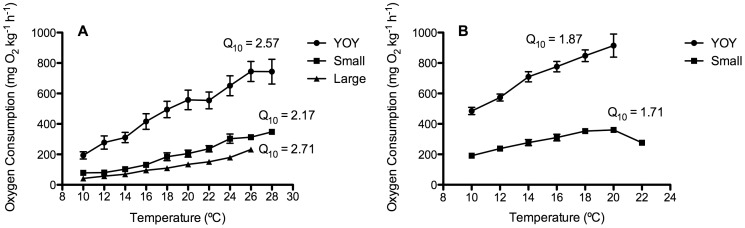
The effect of increasing temperature at 2°C h−1 until loss of equilibrium (CTMax) on oxygen consumption in (A) cunner and (B) Atlantic cod.Each line represents one size class: YOY (0.2–0.5 g), small (3–6 g), or large (∼100 g). Values are means ±1 S.E.